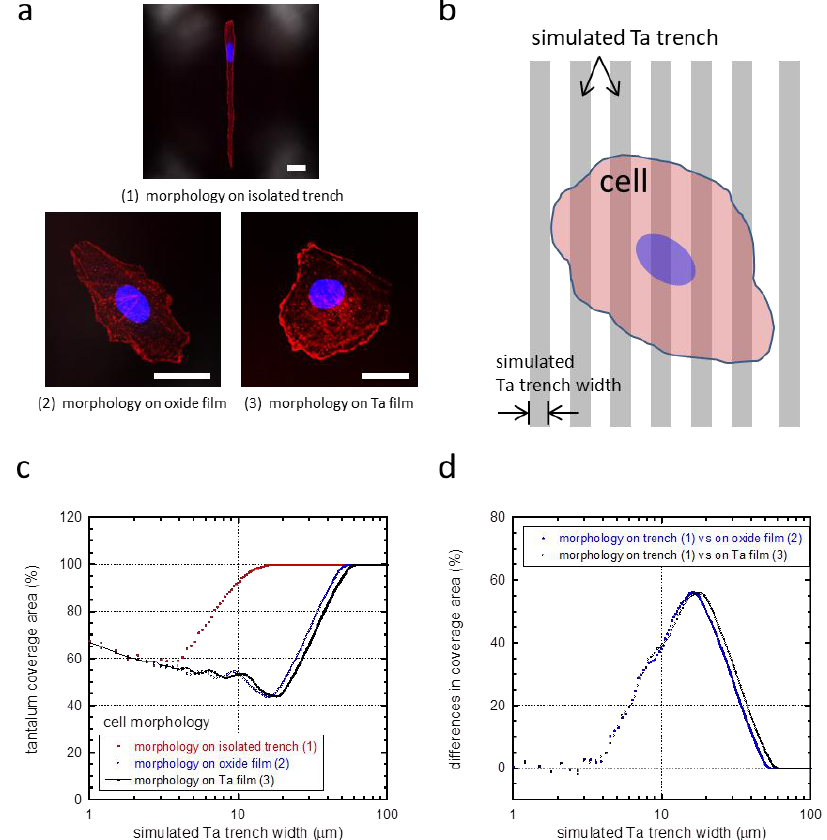
Figure 7. ( a ) Cell morphologies that were used to calculate the tantalum coverage: ( 1 ) on isolated trenches, ( 2 ) on silicon oxide films, and ( 3 ) on tantalum (Ta) films. Scale bars correspond to 25 μm. A schematic drawing illustrating a model cell on simulated parallel trenches and lines is shown in ( b ). ( c ) Percent tantalum coverage calculated from our mathematical simulation of cells with three different morphologies. Tantalum coverage converged at trench widths smaller than 2 μm and larger than 60 μm for all morphologies. ( d ) Difference in tantalum coverage between elongated cell morphology ( 1 ) and a random-shaped cell morphology on blanket oxide ( 2 ) and tantalum films ( 3 ).